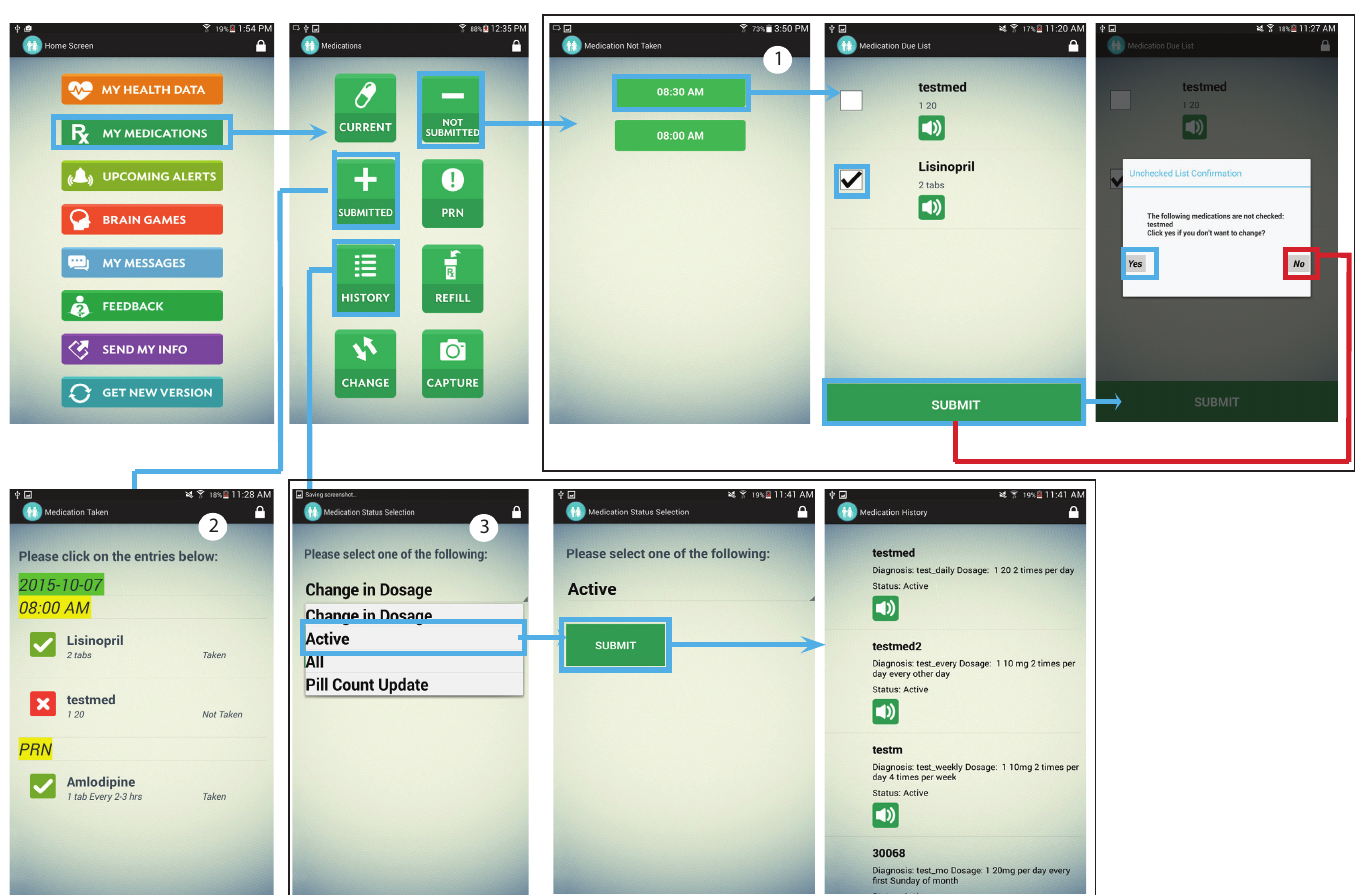
Figure 3. Features of eSeniorCare’s medication component. ( 1 ) Medication submission process, ( 2 ) Submitted medication, and ( 3 ) Subscription